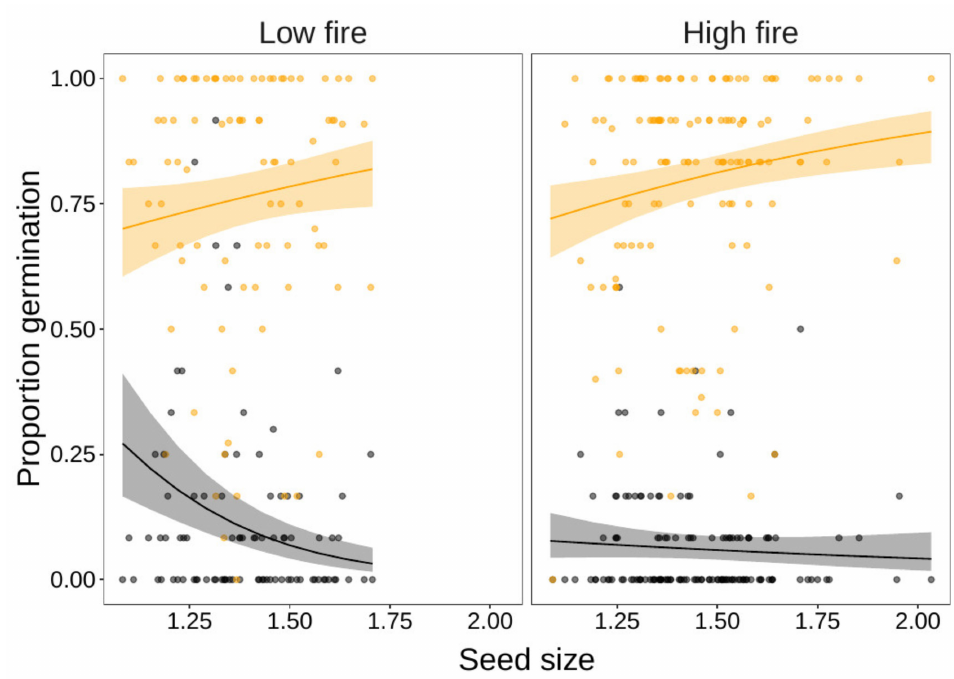
Figure 2. Relationship between germination (proportion germinated) and seed size (mm 2 ) in Cistus salviifolius , in ‘low-fire’ coastal shrubland and ‘high-fire’ Mediterranean heathland habitats. Dots represent plant individuals (grey: control; orange: heat-shock treated). Regression lines and 95% confidence intervals of predicted models are shown (seed size ranged from 1.08 to 2.03). Conditional R 2 = 0.55 and marginal R 2 = 0.52.